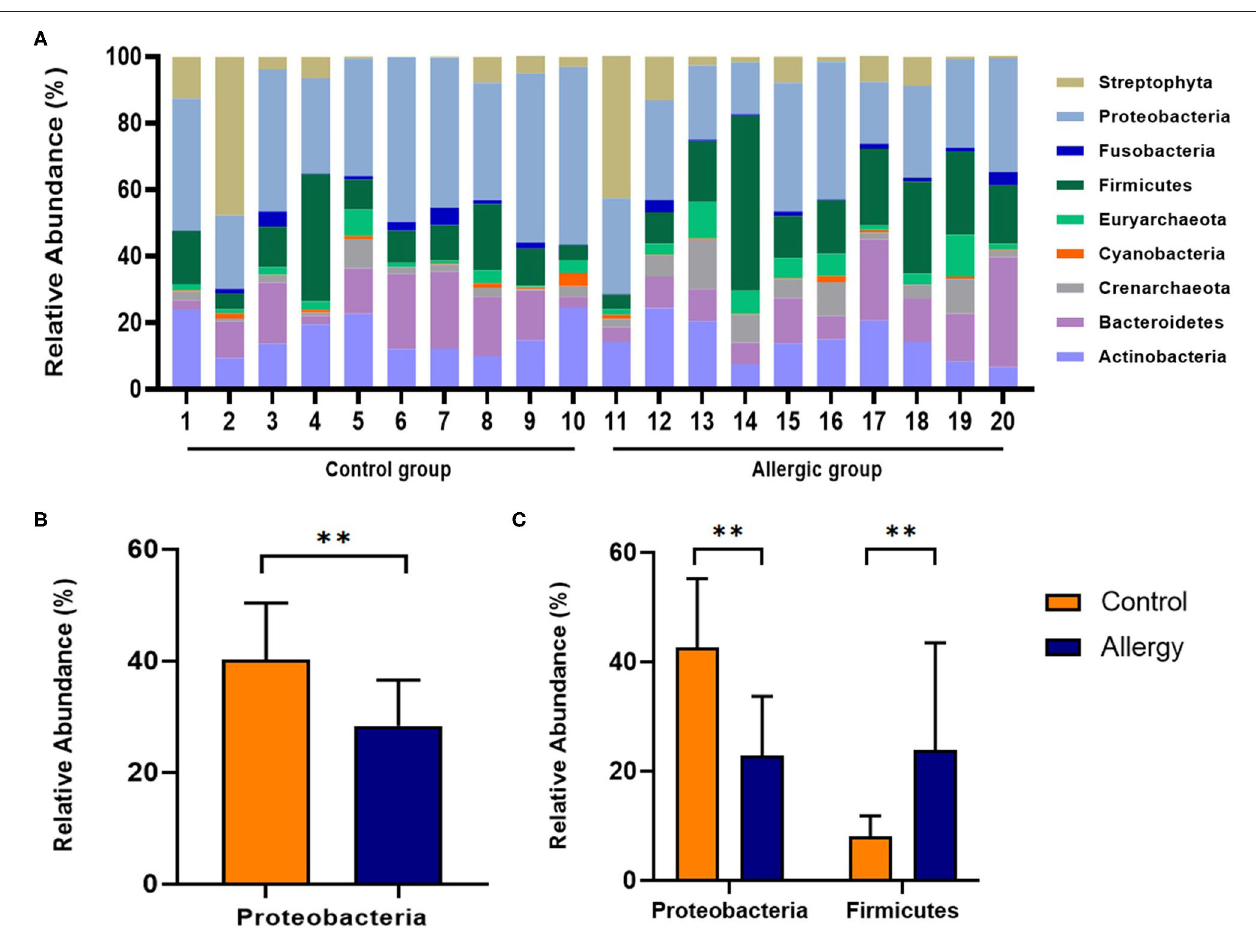
FIGURE 6 | Analysis of the skin microbiome at the phylum level. (A) Individual composition of bacterial phyla in the control and allergic groups. (B) Statistical analysis of the mean relative abundance of the phylum Proteobacteria in axillary region. (C) Statistical analysis of the relative abundance of the phyla Firmicutes and Proteobacteria in the axillary region. All values are expressed as mean ± standard error. ** P <